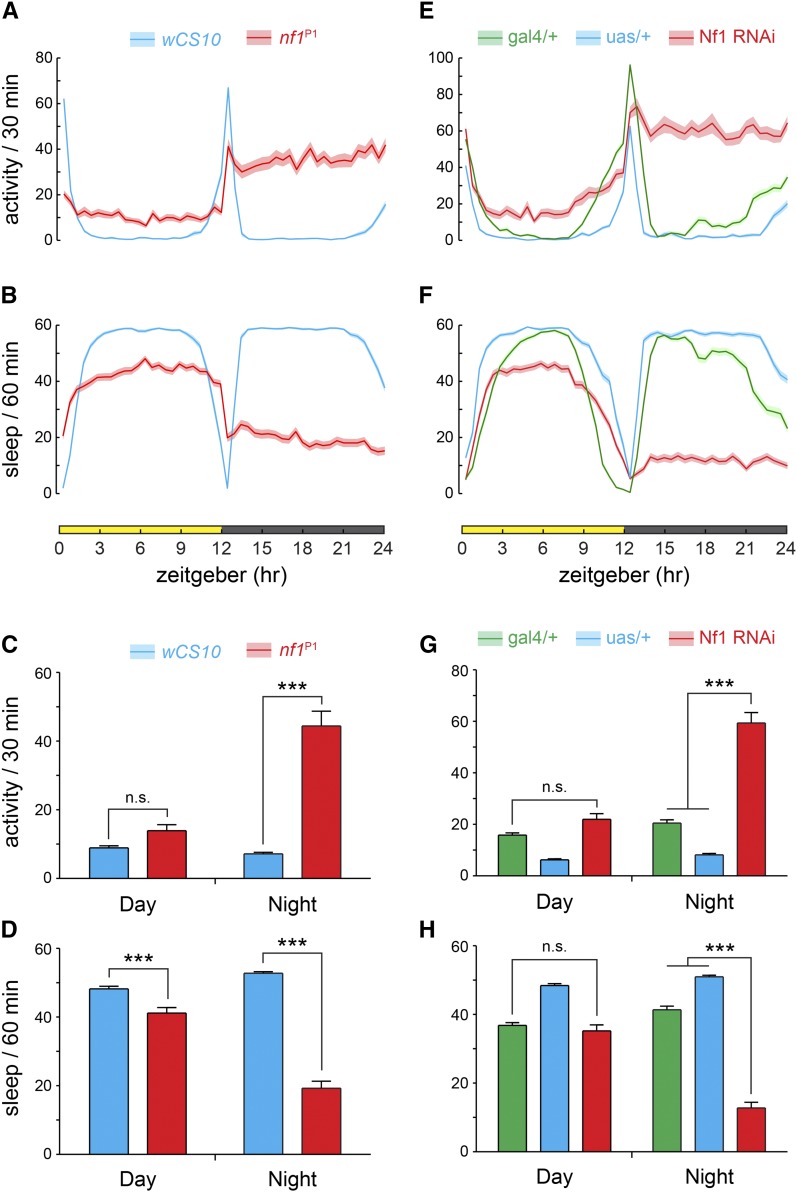
Nf1 mutants and RNAi lines exhibit increased activity and loss of sleep mainly at night, as measured by infrared activity monitors. (A) Activity of nf1P1 (n = 31) and control wCS10 (n = 32) flies across the diurnal cycle, in units of beam counts per 30 min bin. Lines and shading represent mean ± SEM. (B) Sleep plots of the nf1P1 mutants and wCS10 controls. (C) Daytime and nighttime activity for nf1P1 mutants and wCS10 controls. Bars and whiskers represent mean ± SEM. *** P < 0.001 (ANOVA/Sidak); n.s., not significant. (D) Daytime and nighttime sleep for nf1P1 mutants and wCS10 controls. *** P < 0.001 (ANOVA/Sidak). (E) Activity in Nf1 RNAi lines and controls across the diurnal cycle, in units of beam counts per 30 min bin. Full genotypes: gal4/+ = w;uas-dcr2/+;nSyb-gal4/+ (n = 31), uas/+ = w;uas-dcr2/uas-nf1RNAi (n = 32), Nf1 RNAi = w;uas-nf1RNAi/uas-dcr2;nSyb-gal4/+ (n = 32). (F) Sleep plots of the Nf1 RNAi lines and controls. (G) Daytime and nighttime activity for Nf1 RNAi lines and controls. *** P < 0.001 (ANOVA/Sidak); n.s., not significant. (H) Daytime and nighttime sleep for Nf1 RNAi lines and controls. *** P < 0.001 (ANOVA/Sidak); n.s., not significant.